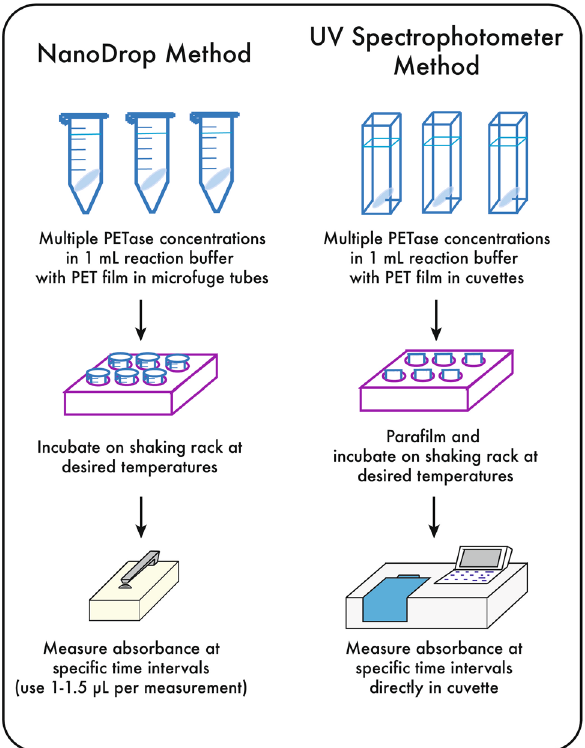
Figure 5. Summary of bulk absorbance method using a NanoDrop (ThermoFisher Scientific) or UV